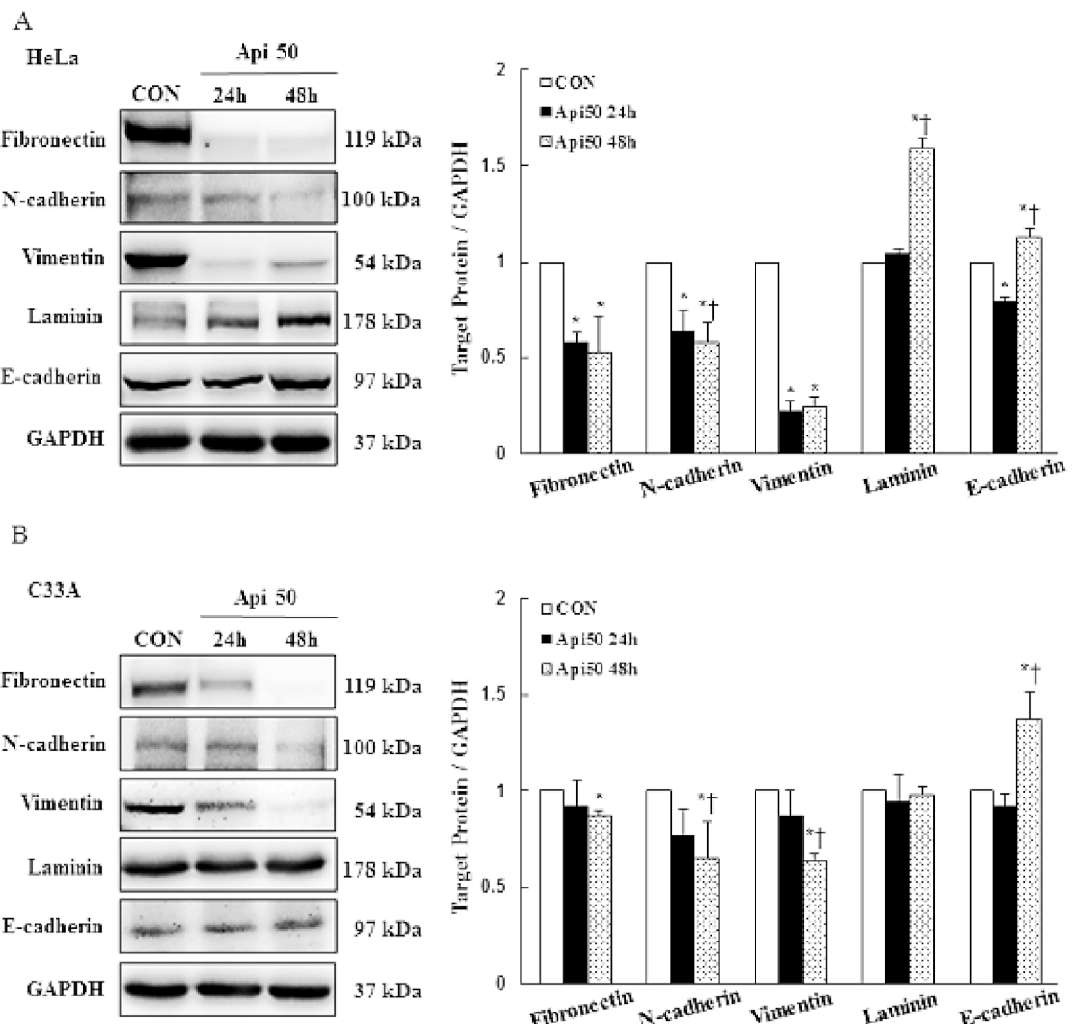
Figure 5. Apigenin disrupts cancer cell metastasis and inhibits epithelial-to-mesenchymal transition. Proteins fibronectin, N-cadherin, vimentin, laminin, and E-cadherin were detected in HeLa ( A ) and C33A ( B ) cells with or without 50 µ M apigenin treatment for 24 and 48 h via Western blotting and quantified. Data are presented as the mean ± SD of at least three independent experiments. * and † p < 0.05 indicate significant differences as compared with the corresponding control or Api 50- treated groups. CON, 0.1% DMSO; Api50 24 h, 50 µ M apigenin at 24 h; Api50 48 h, 50 µ M apigenin at 48